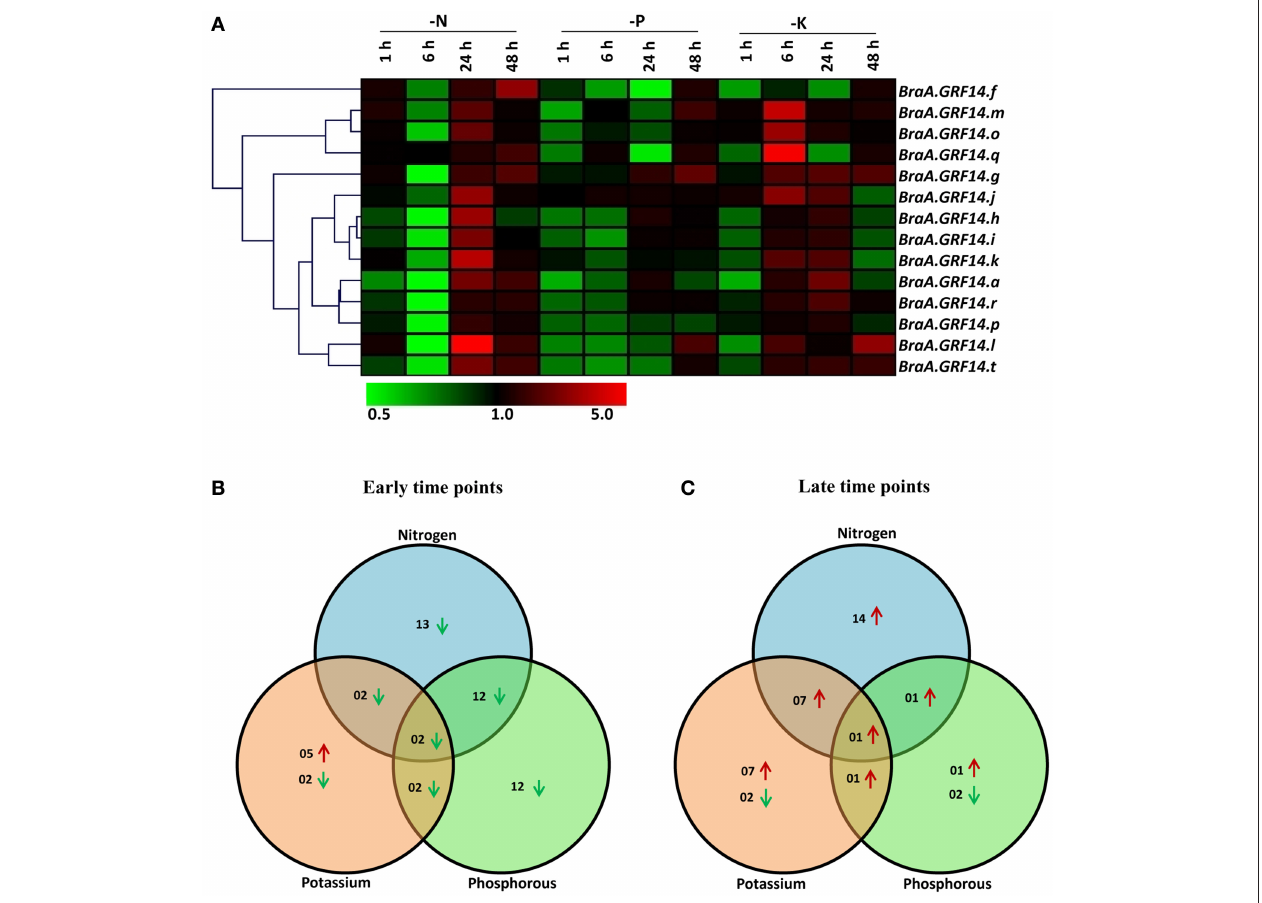
FIGURE 6 | Expression profile of BraA.GRF14 genes during nutrient deprivation conditions in 5 days old B. rapa seedlings. (A) A heat map representing hierarchical clustering of average fold change of BraA.GRF14 gene expression in response to nutrient deprived conditions at different time points (mentioned at the top of each lane). The 5 days old B. rapa seedlings were harvested at different time points (1, 6, 24, and 48 h) after they were exposed to nutrient solution lacking Nitrogen (N), Phosphorus (P), and Potassium (K). The mock treated seedlings of same time interval served as control (set at 1) and expression was normalized with ACT2 gene. The color scale representing average signal is shown at the bottom of the heat map. The Venn diagrams represent the total number of BraA.GRF14 genes which were upregulated (red upward arrow) and down-regulated (green downward arrow) during (B) early (1 and 6 h), and (C) late (24 and 48h) nutrient deprived conditions.